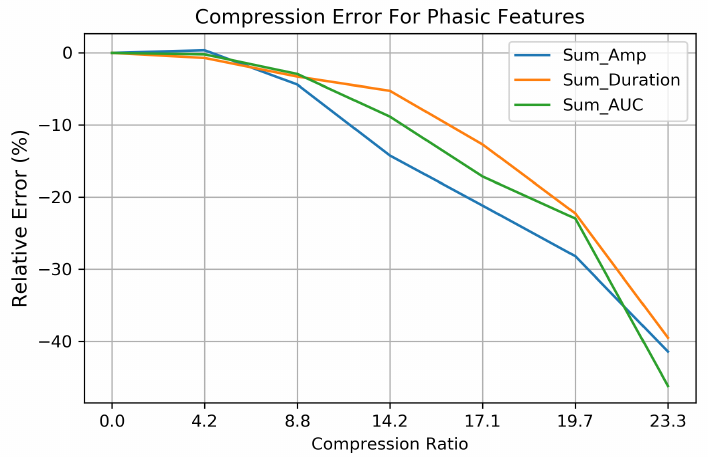
Figure 10. The relative error for the phasic EDA features—Sum of Area Under the Curve, Sum of SCR amplitudes, and the Sum Duration over 253 EDA signals. Reconstruction errors are increased significantly above compression ratios of 8.8 × , due to the loss of low-amplitude SCRs not being during the compression